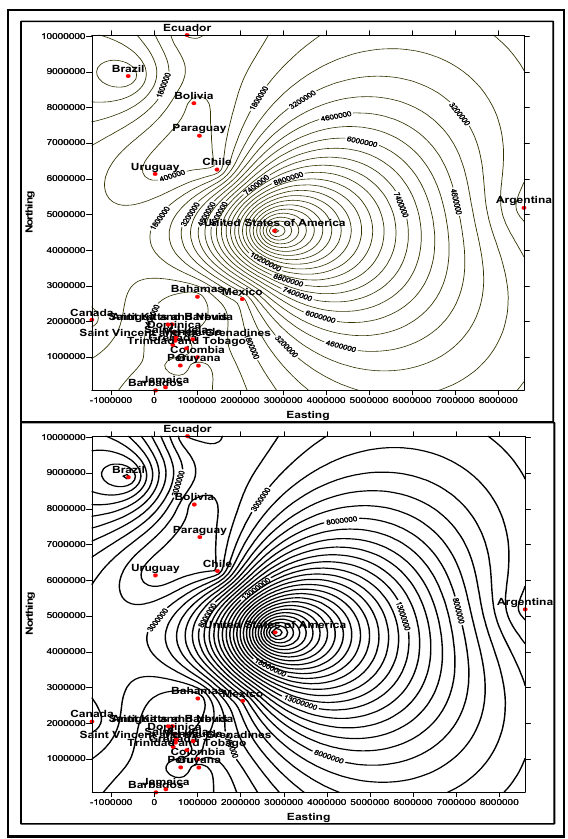
Figure 19. Map view showing diabetes reporting for Americas region for years 2000 and